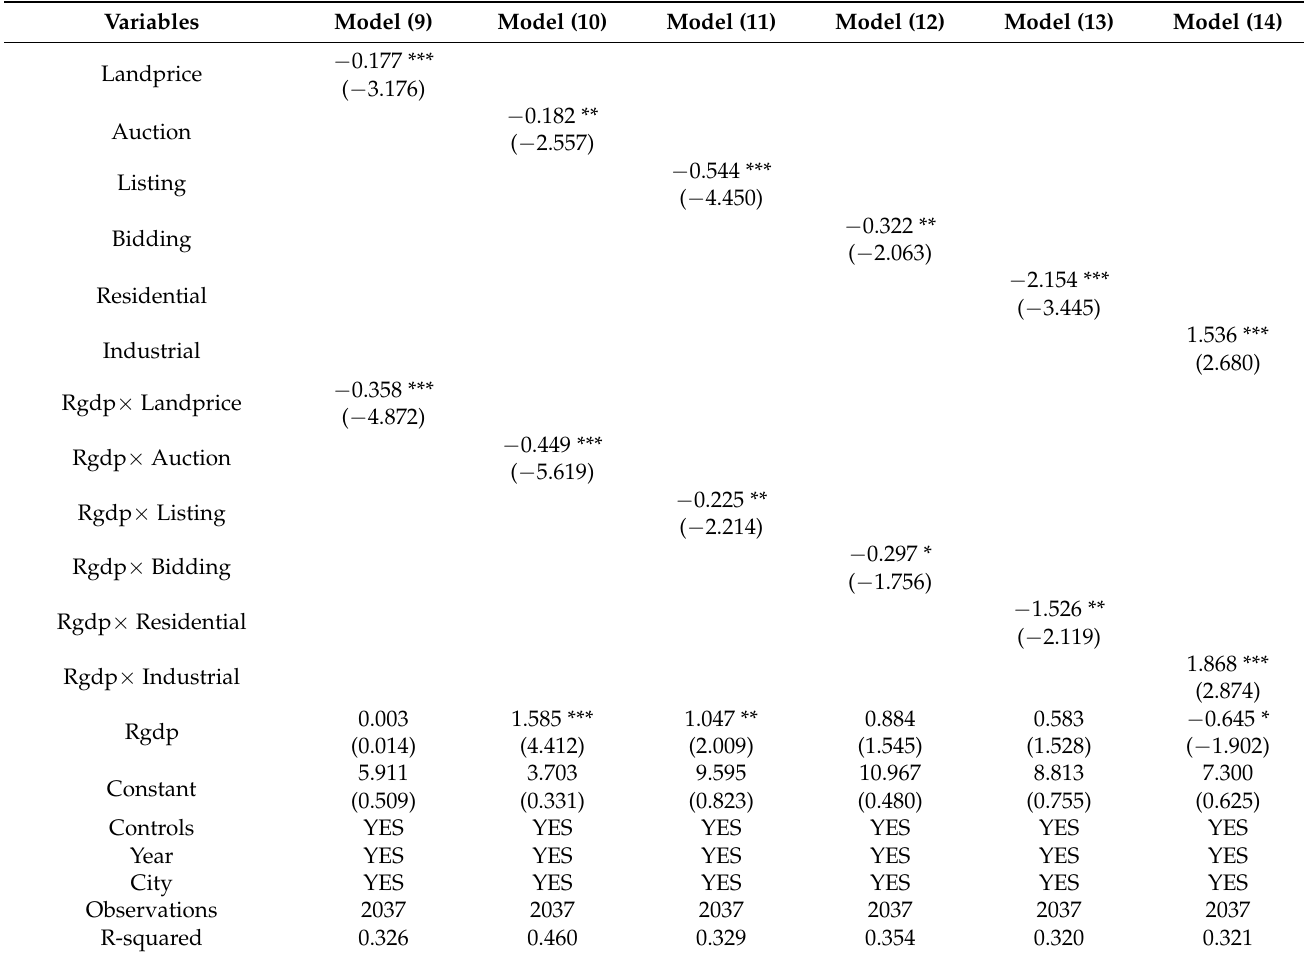
Table 7. Regression results of moderating effect of